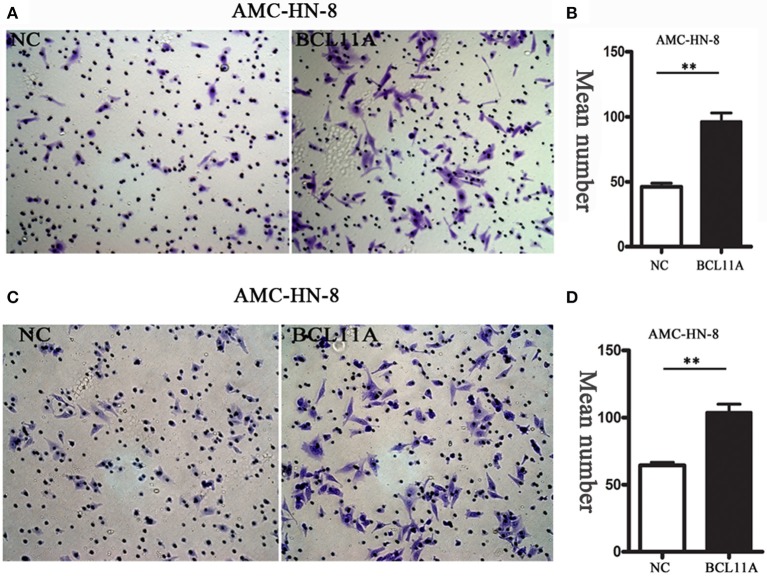
The migration/ invasion ability of LSCC cells with overexpression in the transwell assay. (A) Increased migration capability of BCL11A-overexpression AMC-HN-8 cells detected by the transwell assay. Images showing the migrated AMC-HN-8 cells on the lower surface of the transwell membranes. Magnification ×200. (B) The numbers of migrated AMC-HN-8 cells in five random fields under the microscope (mean ± SD, n = 5). (C) Increased invasion capability of BCL11A-overexpression AMC-HN-8 cells. Images showing the invaded BCL11A-overexpresing AMC-HN-8 cells on lower surface of the transwell membranes in different groups. Magnification ×200. (D) The number of invaded BCL11A-overexpressing AMC-HN-8 in five random fields under the microscope (mean ± SD, n = 5). **P < 0.01.